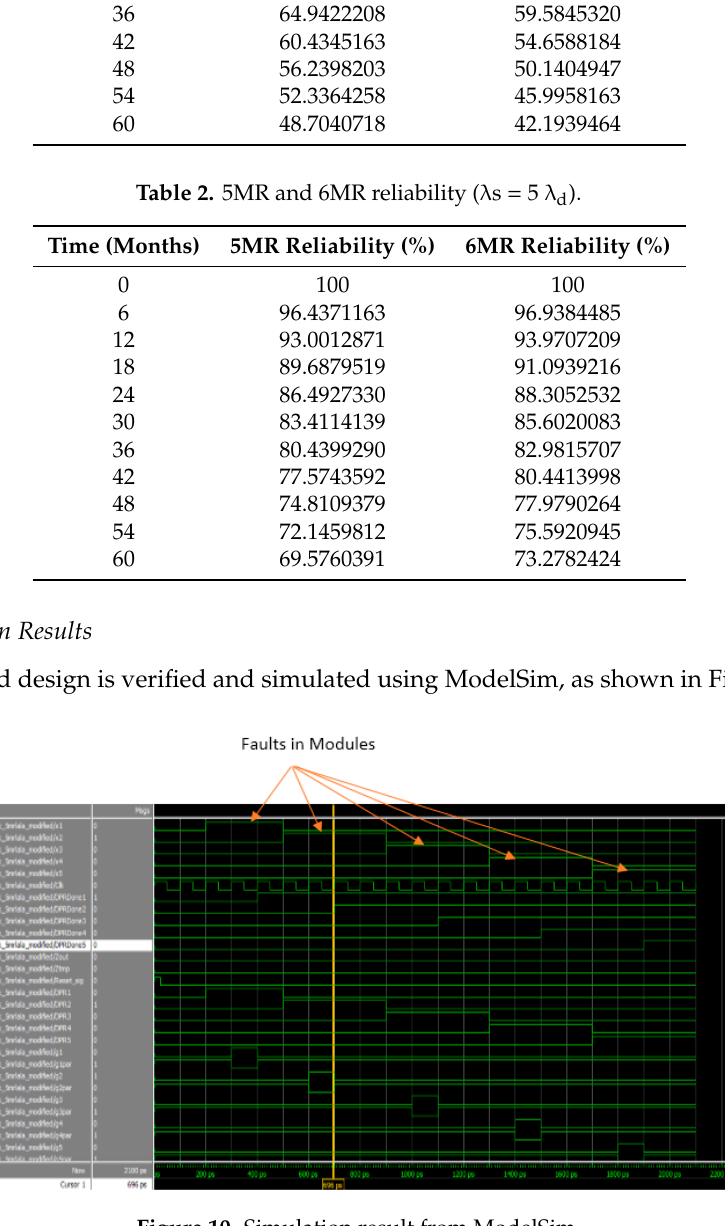
Table 3. Implementation results of the proposed design.